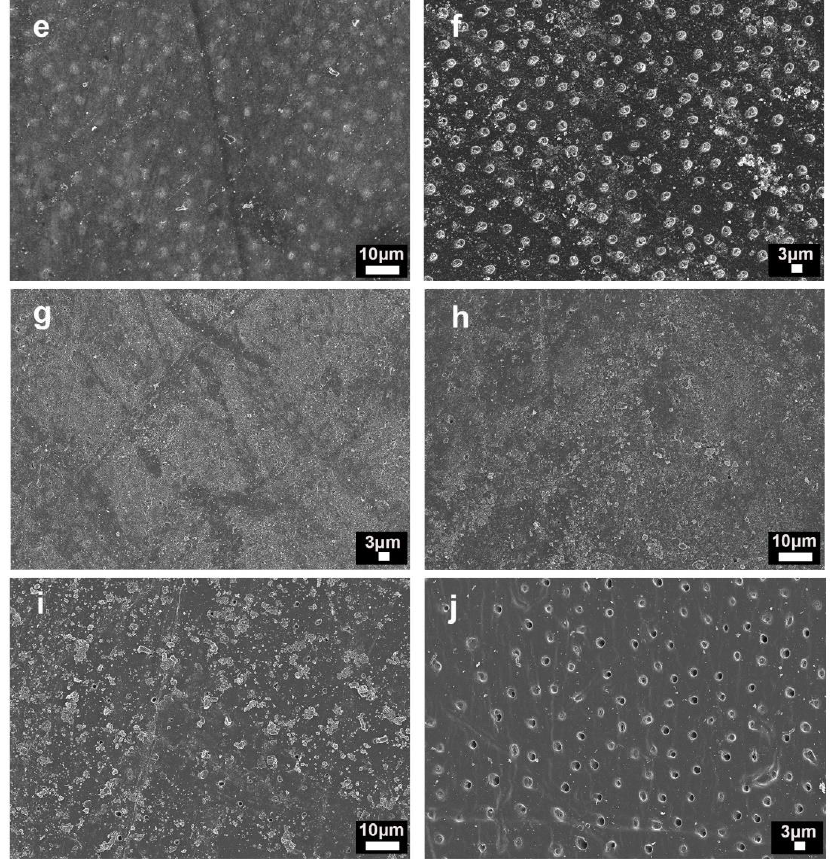
Figure 3. FESEM images of the dentin surfaces after EDTA-treatment and: ( a ) brushed with distilled water and ( b ) after-treated with citric acid; ( c ) brushed with toothpaste containing 1% of Zn-NPs and ( d ) after-treated with citric acid; ( e ) brushed with toothpaste containing 5% of Zn-NPs and ( f ) after-treated with citric acid; ( g ) brushed with toothpaste containing 10% of Zn-NPs, and ( h ) after-treated with citric acid; and ( i ) brushed with Sensodyne ® toothpaste and ( j ) after-treated with citric acid. All images are taken at 2500 ×